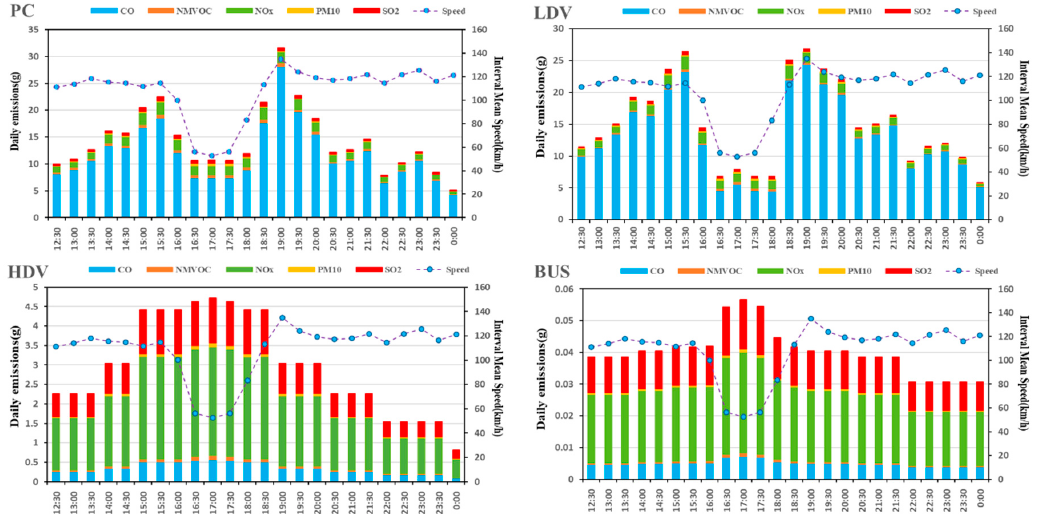
Figure 9. The dynamic variance of each vehicle emissions at each phase.